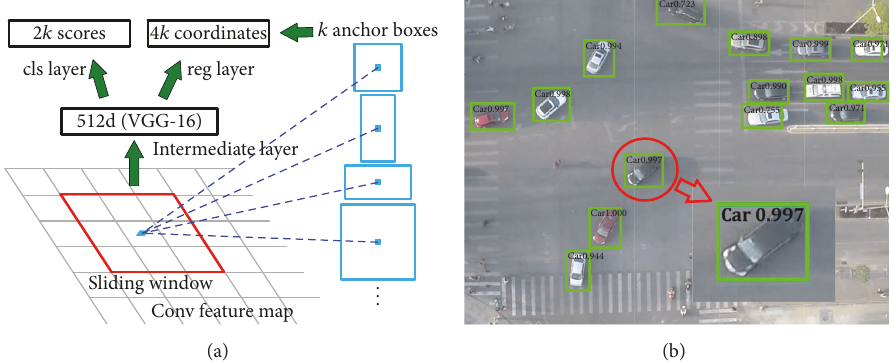
Figure 3: (a) Region Proposal Network (RPN), from [21]. (b) Car detection using RPN proposals on our UAV